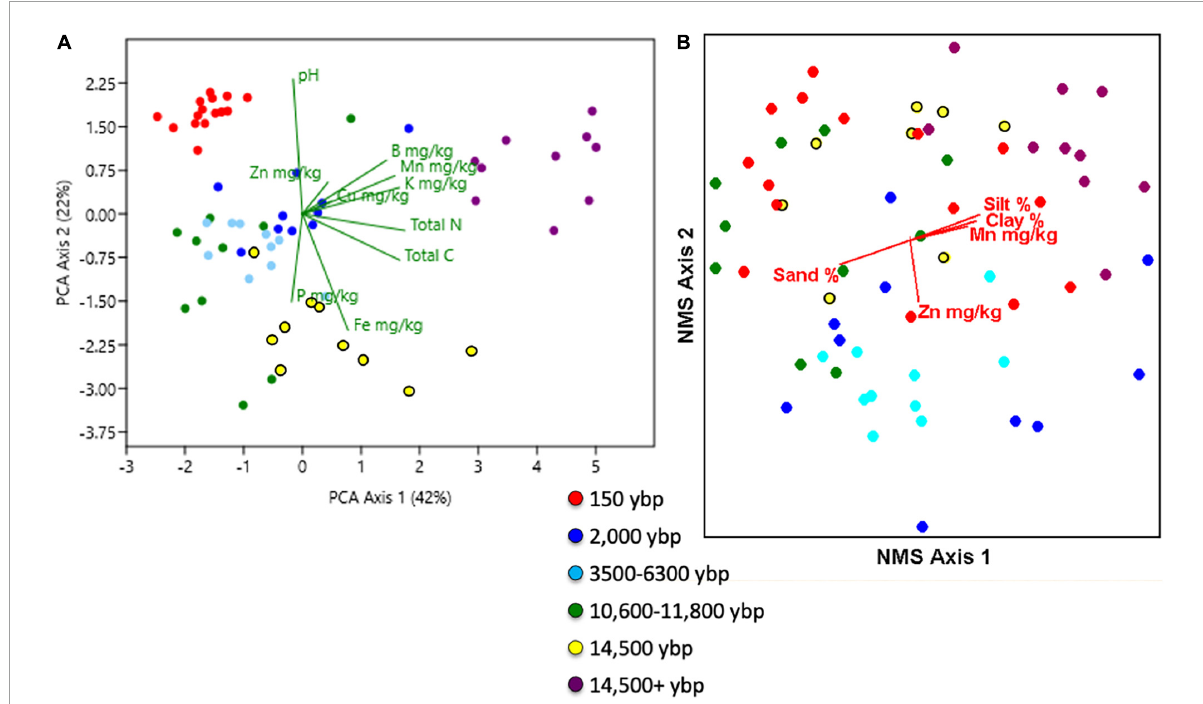
FIGURE1 (A) Two dimensional principal components analysis (PCA) of Asian bittersweet bulk soil sample chemistry among the 13 sites. (B) Two dimensional non-metric multidimensional scaling ordination of vegetation presence/absence by species. Red biplots show the direction and magnitude of soil environmental variable corelates with vegetation composition. For both plots, each dot represents a sample and is colored by dune ages listed in the legend. Chemical abbreviations are B = boron, C = carbon, CU = copper, Fe - iron, K= potassium, Mn = manganese, N = nitrogen, P = phosphorous, and Zn = zinc. Samples were collected at Indiana Dunes National Park in 2017.